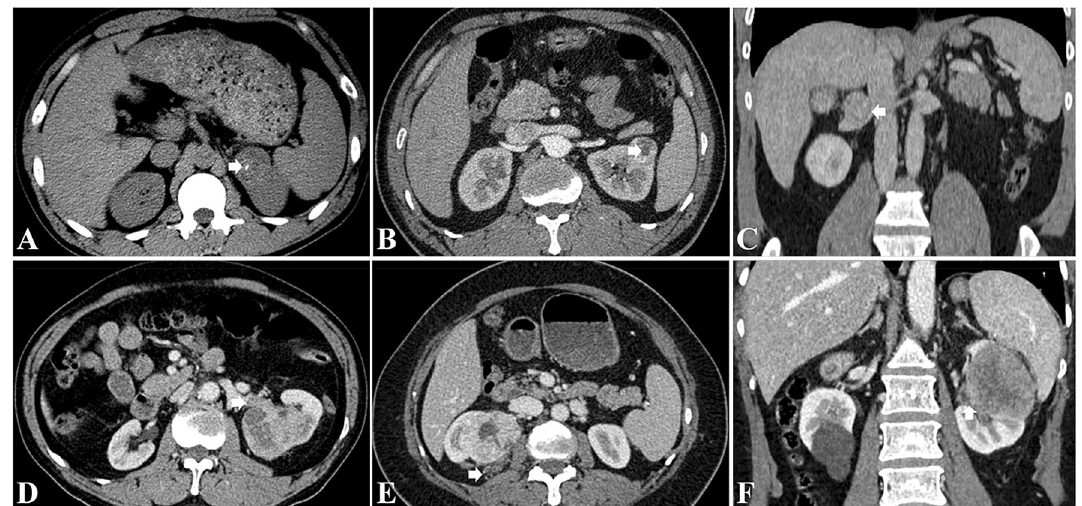
Figure 3. CT imaging features as assessed by both readers: ( A ) calcification; ( B ) necrosis; ( C ) renal vein invasion; ( D ) renal vein thrombus; ( E ), perirenal fat invasion; ( F ) renal sinus